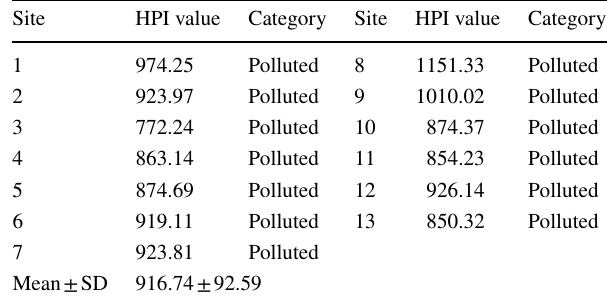
Table 7 Heavy metal pollution index (HPI) of the measured metals in Mariout Lake water according to the guideline levels for aquatic